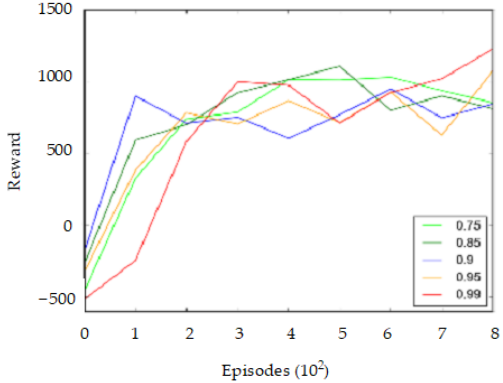
Figure 17. Average cumulative reward obtained by a DDQN agent for different discount factor values in the Gazebo simulator.